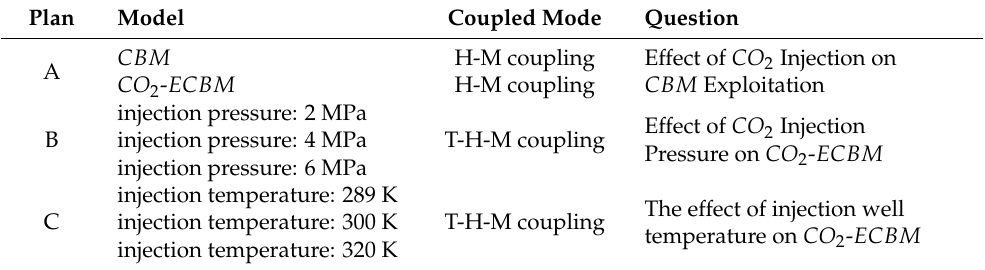
Table 4. Simulation program.